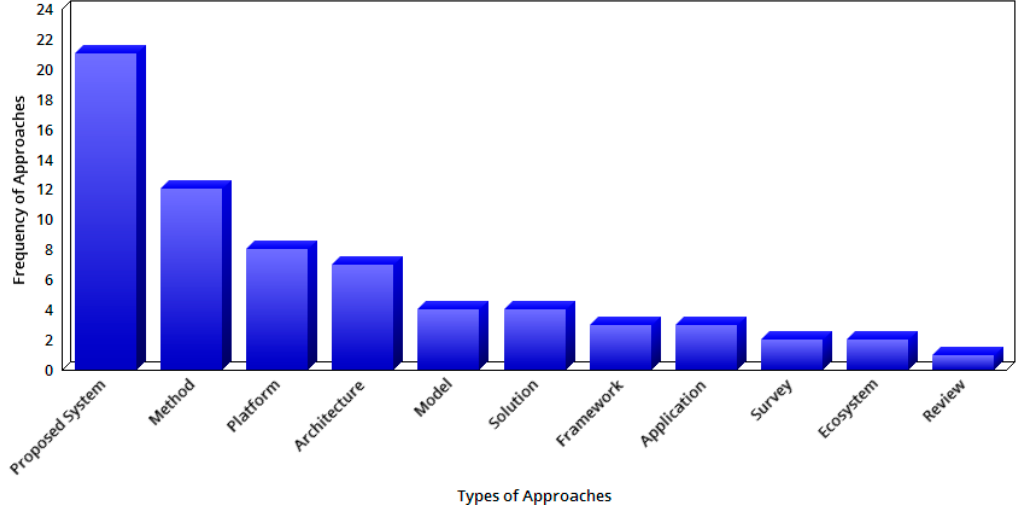
Figure 3. Research Approaches in IoT Agriculture.